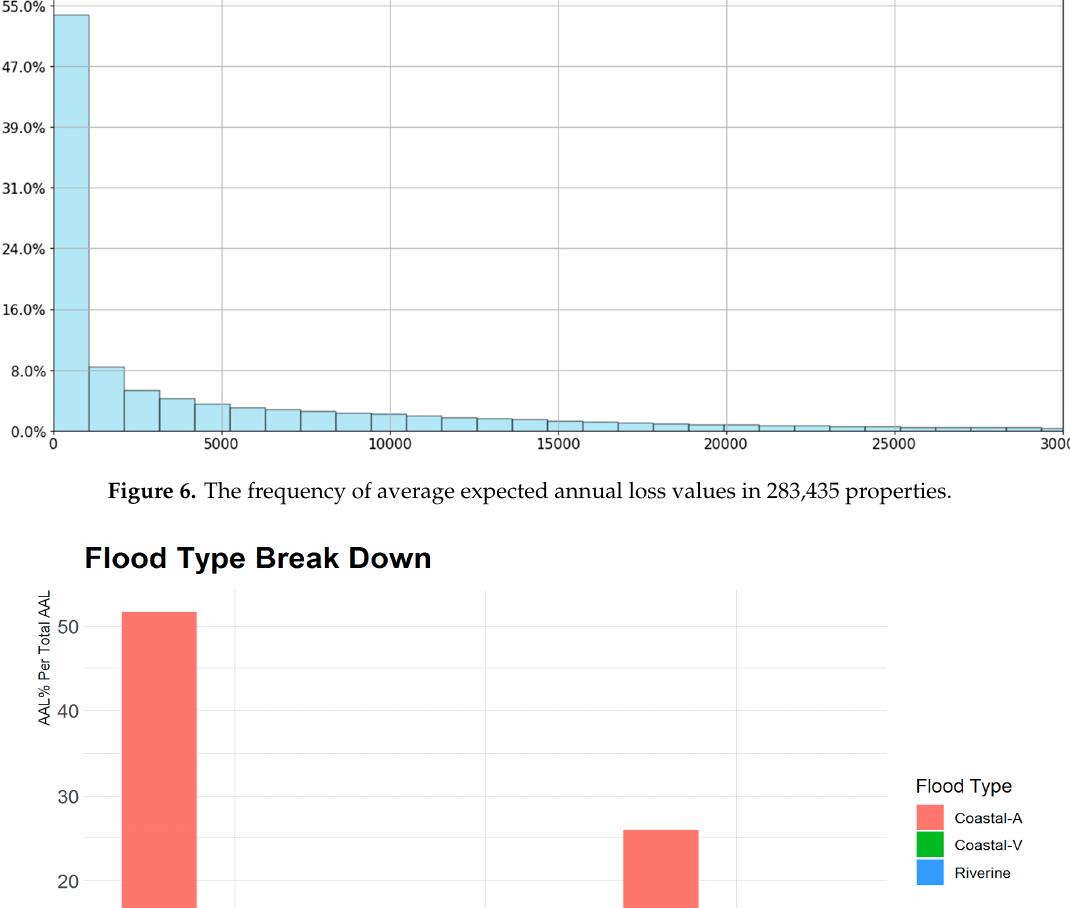
Figure 6. The frequency of average expected annual loss values in 283,435 properties.